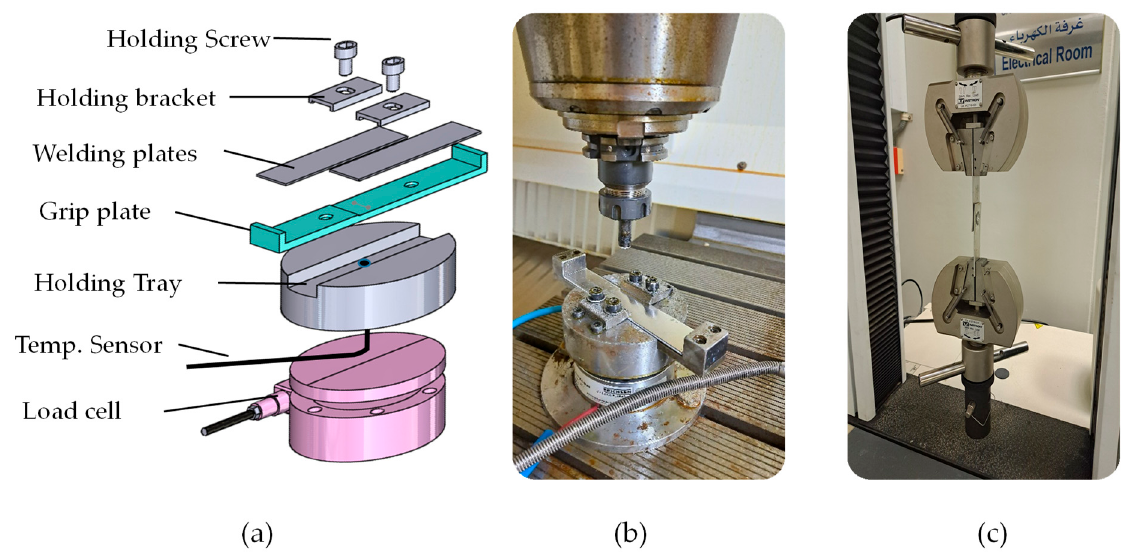
Figure 4. Experimental setup: ( a ) parts of the fixture; ( b ) machine setup; and ( c ) tensile test setup.